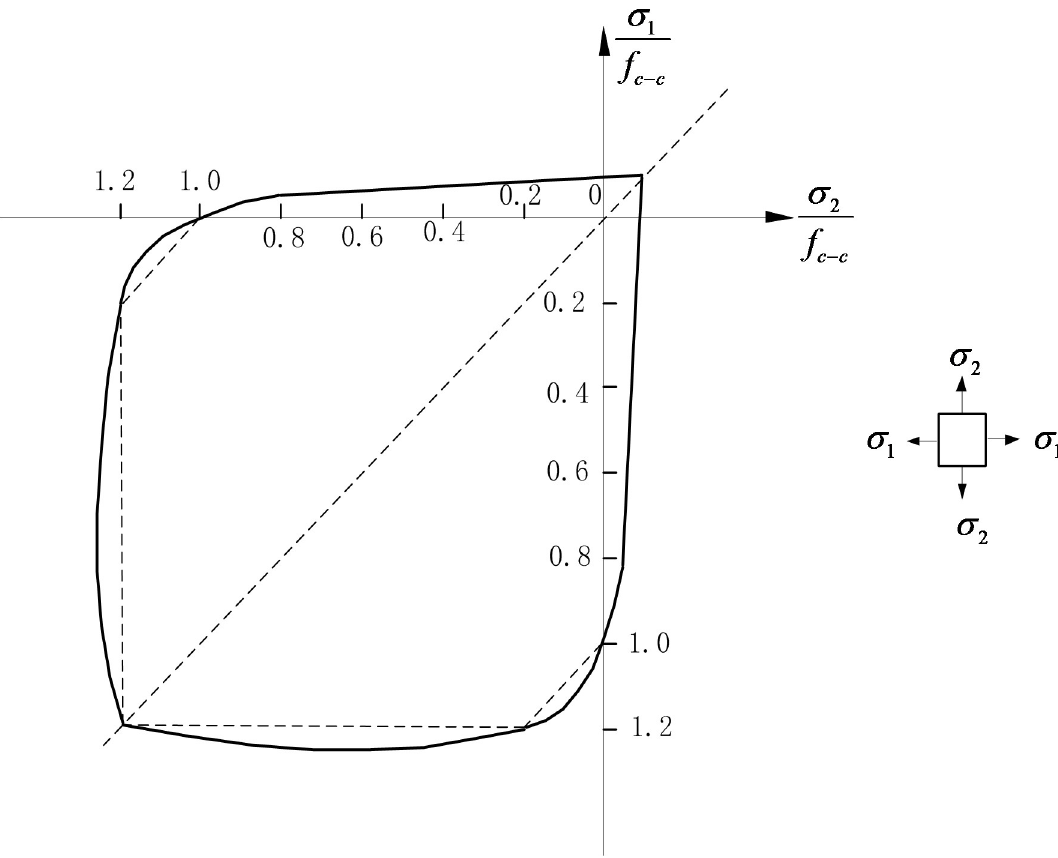
Fig 4. Strength criterion of concrete under biaxial stress state [29]. σ 1 and σ 2 are the biaxial stress value. f strength of